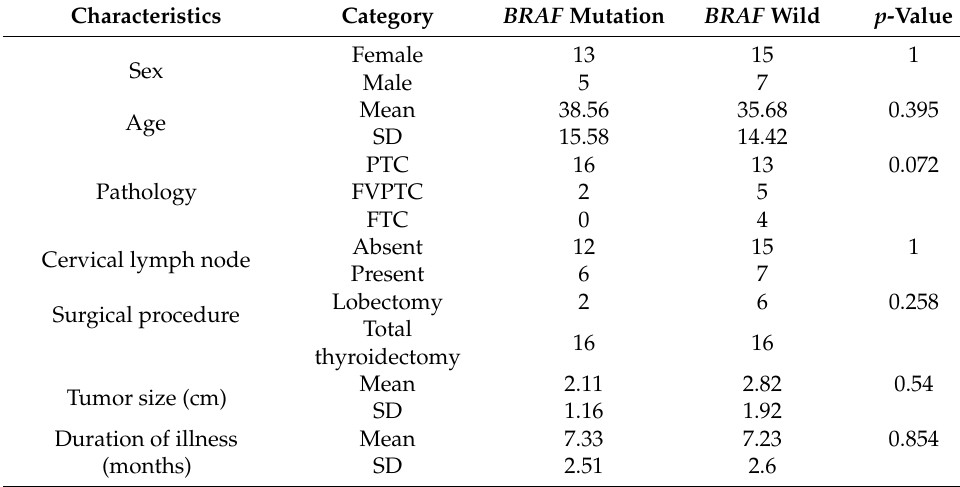
Table 1. Characteristics of the patients.